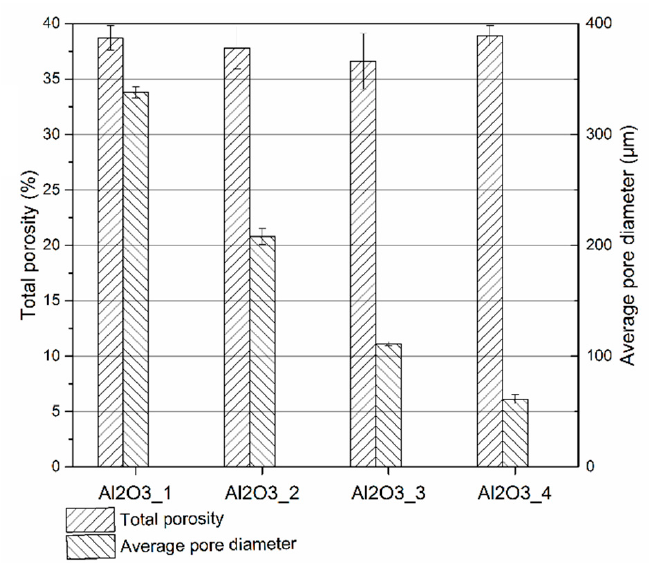
Figure 4. Total porosity and average pore diameter for Al 2 O 3 _1, Al 2 O 3 _2, Al 2 O 3 _3, and Al 2 O 3 _4 ceramic preforms.